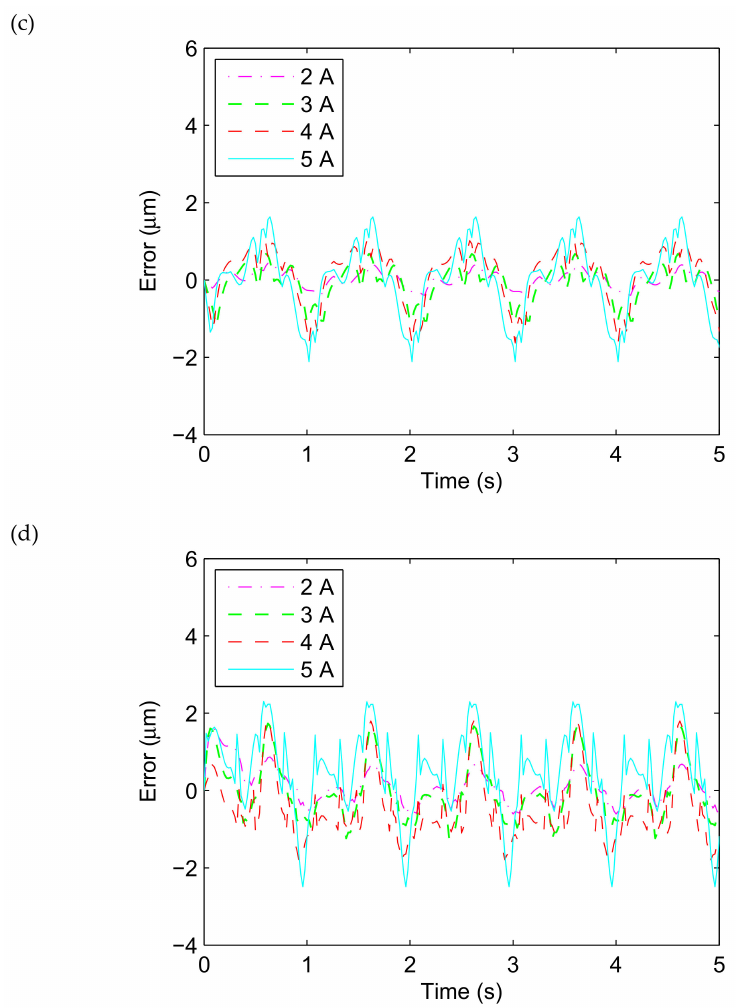
Figure 9. Time history of the displacement di ff erence between experimental results and the fitted results of the established ISSF-Duhem model and the PD-Model when the magnetostrictive actuator under 1 Hz harmonic input with di ff erent currents: ( a ) G-Model: the ISSF-Duhem model with Grompertz function-based shape function, ( b ) M-Model: the ISSF-Duhem model with modified hyperbolic tangent function-based shape function, ( c ) D-Model: the ISSF-Duhem model with a one-sided dead-zone operator-based shape function, and ( d ) PD-Model: the modified Prandtl–Ishlinskii model with a one-sided dead-zone